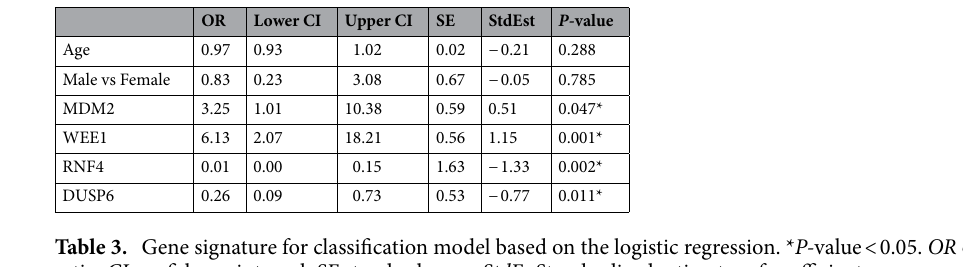
Table 3. Gene signature for classification model based on the logistic regression. * P- value < 0.05. OR odds ratio, CI confidence interval, SE standard error, StdEs Standardized estimates of coefficient.